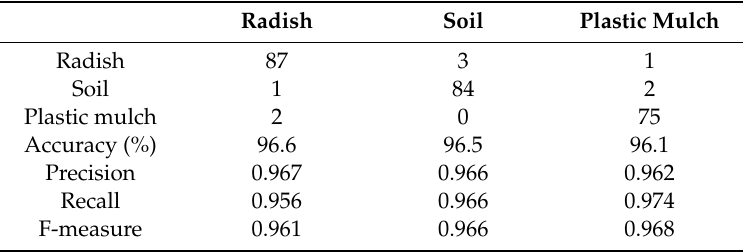
Table 4. Confusion matrix on the RGB-region of interest (ROI) testing dataset using the proposed deep learning